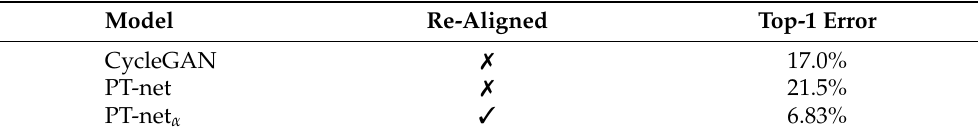
Table 4. Results of different models trained with jittered data.